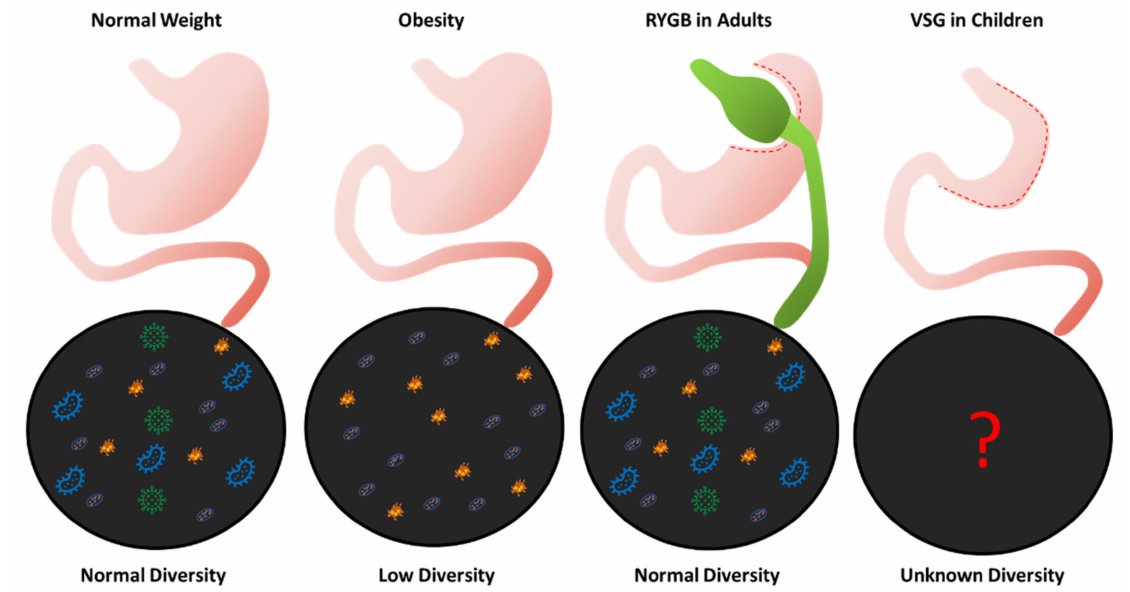
Figure 2. The diversity of gut microbiota in the human gut: The four images indicate the degree of gut microbial diversity in the intestines in patients with a normal weight, with obesity, and after RYGB, and the unknown nature of gut microbial diversity after VSG in children. The gut microbiota of a patient with a normal weight has a high degree of microbial diversity, which contributes to the maintenance of health. Patients with obesity have dysbiosis in their gut microbiome marked by a lack of microbial diversity. RYGB, which has been the subject of most studies examining the link between bariatric surgery and gut microbial diversity, effectively leads to weight loss and restores the dysbiosis to levels of gut microbial diversity seen in patients with a normal weight. In contrast, the most common type of bariatric surgery performed in children is VSG and the effects to the microbiome before and after VSG in children is